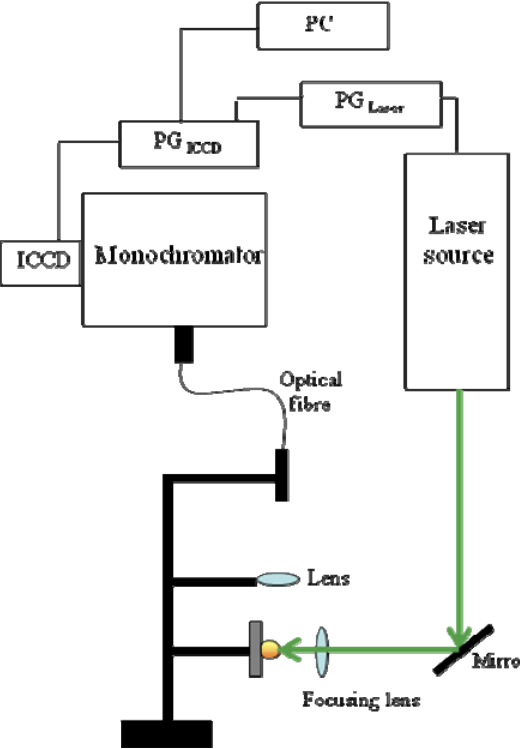
Figure 1. Block diagram of a typical experimental set-up for Single Pulse LIBS experiments. The acronym PG stands for Pulse